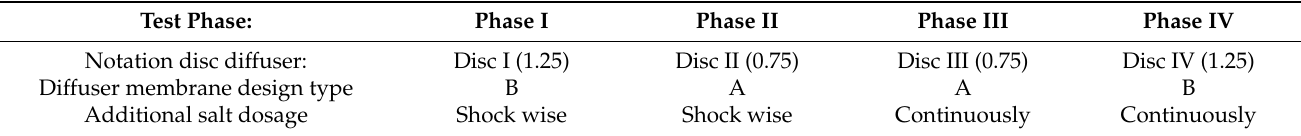
Table 3. Overview of the test